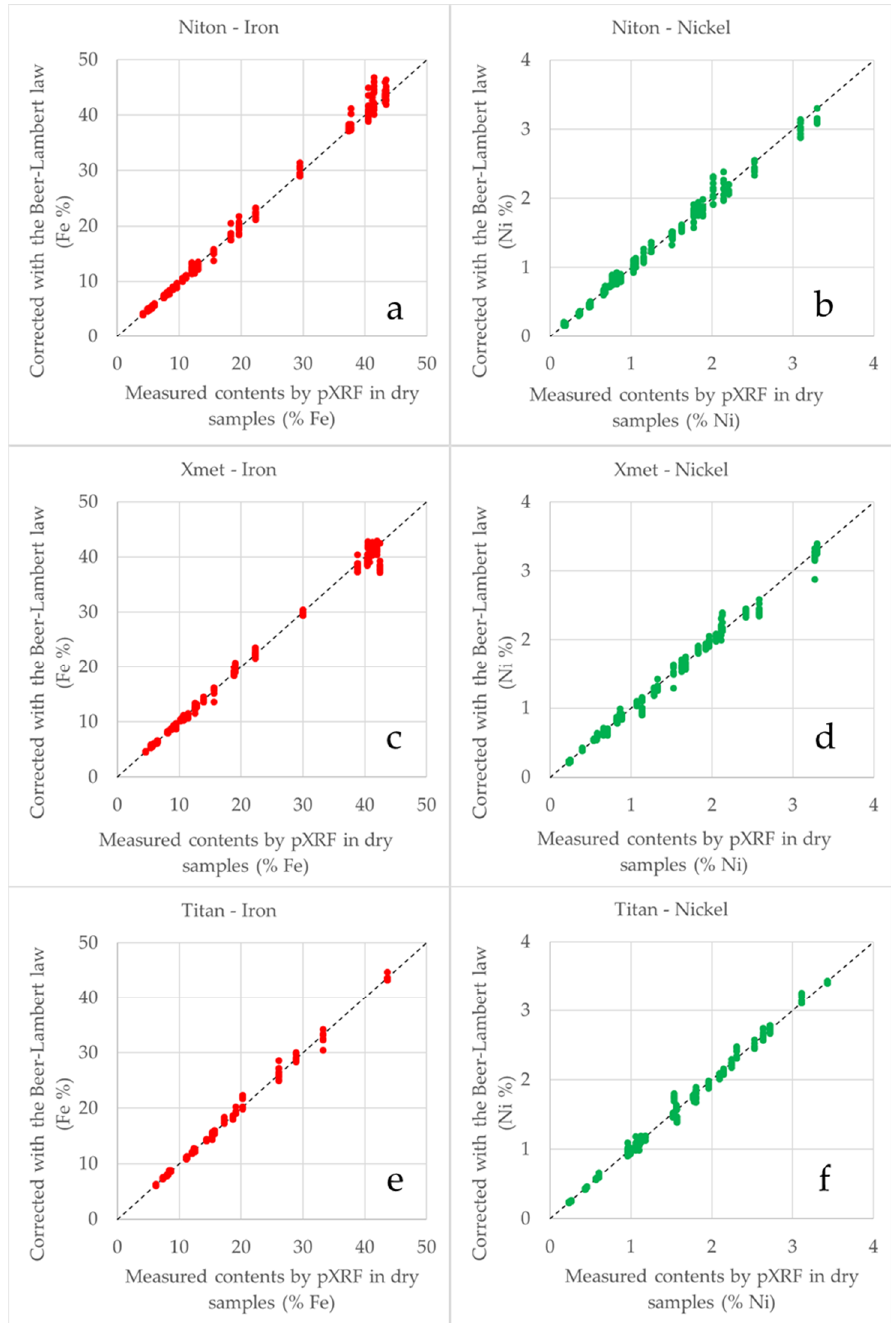
Figure 12. Ni and Fe concentrations after correction with the Beer-Lambert law: ( a , b ) Niton, ( c , d ) Xmet and ( e , f ) Titan.